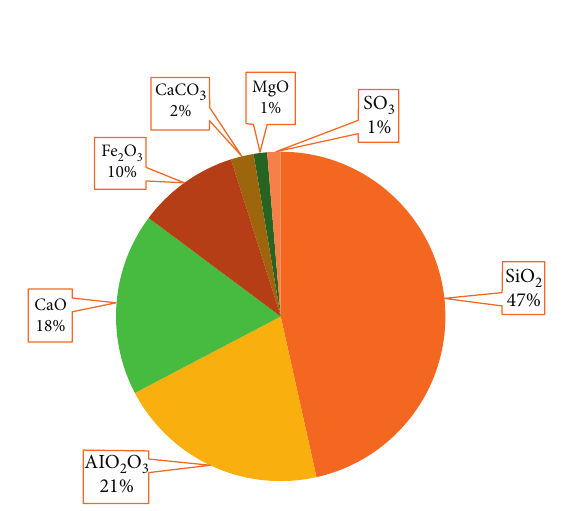
Figure 6: Chemical composition of fly ash. Table 2: Specification of nanosilica. Item